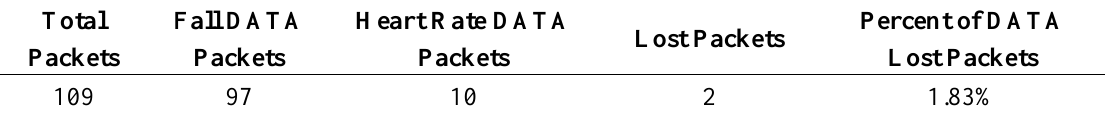
Table 6. Received DATA